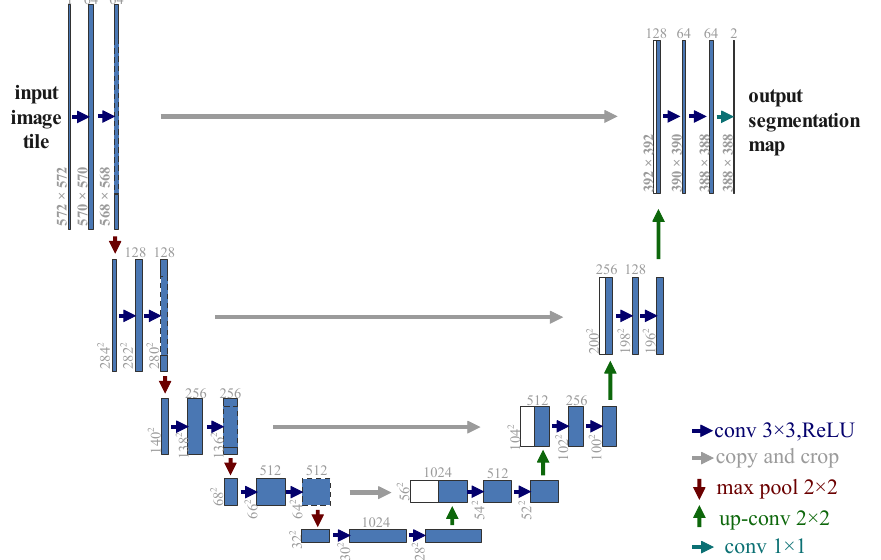
Figure 1. U-Net architecture. The blue box represents the multichannel feature layer. The channel number is shown at the top of the box. The white boxes represent the replicated feature maps. The arrows represent operations on the feature